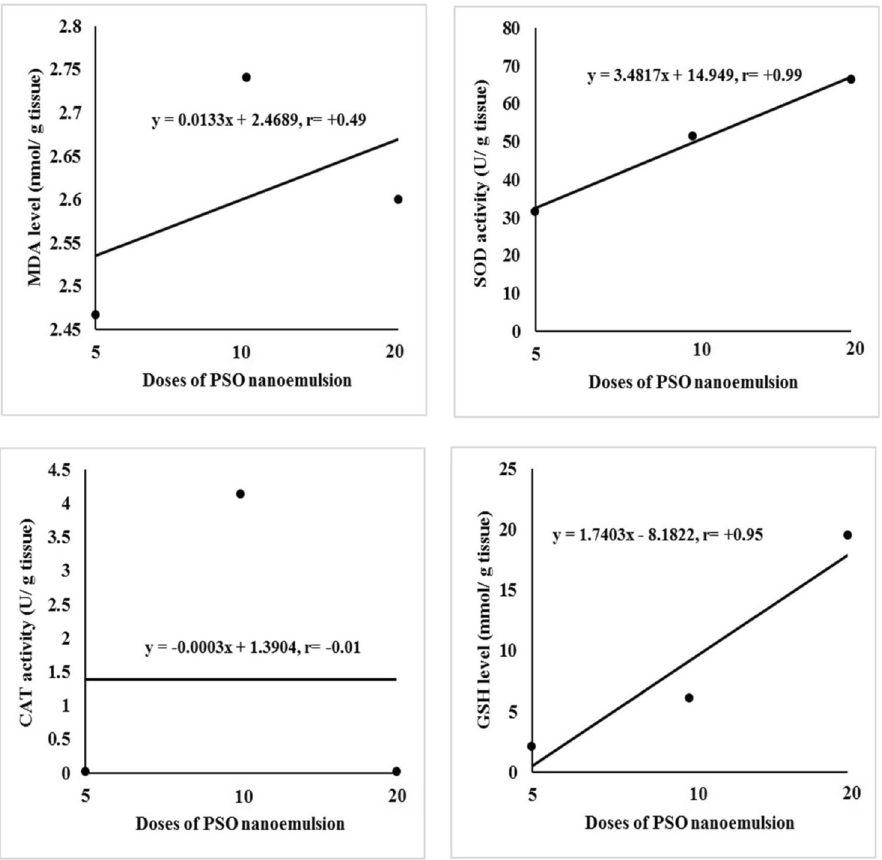
Figure 13. Regression analysis of the levels of MDA and GSH as well as the activities of SOD and CAT in the three groups administered different doses of PSO nano-emulsion (5, 10 and 20% of PSO LD50). r: Pearson’s correlation